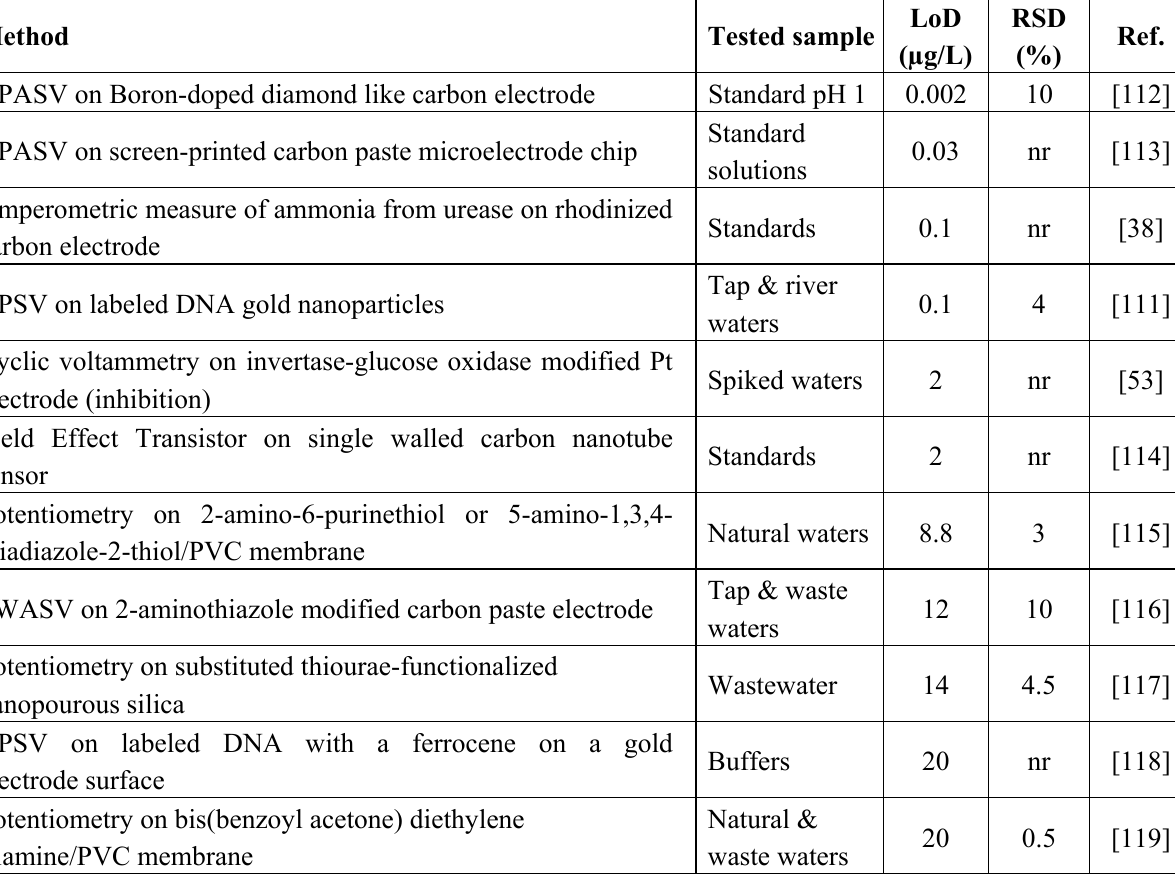
Table 6. Analytical characteristics of electrochemical sensors for mercury determination in water, published between 2007 and